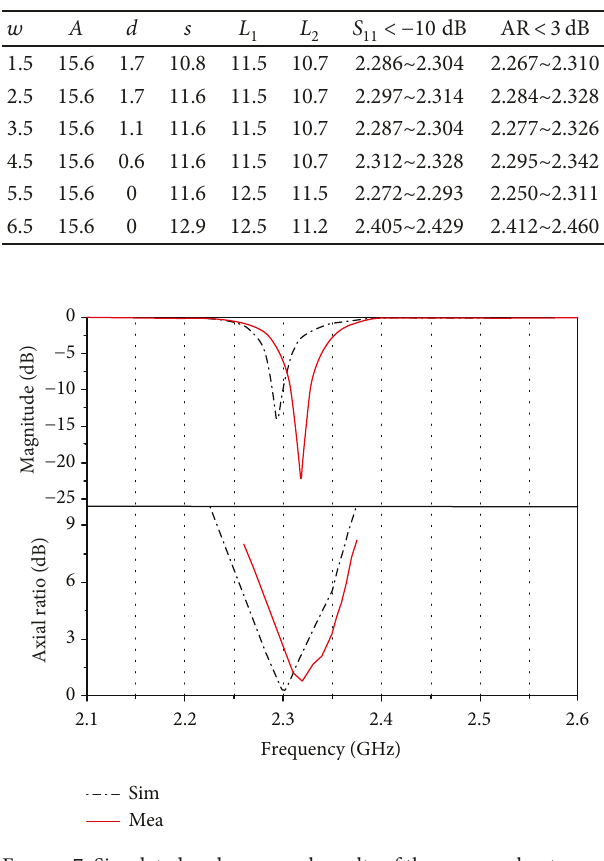
Figure 7: Simulated and measured results of the proposed antenna: re fl ection coe ffi cient and AR.